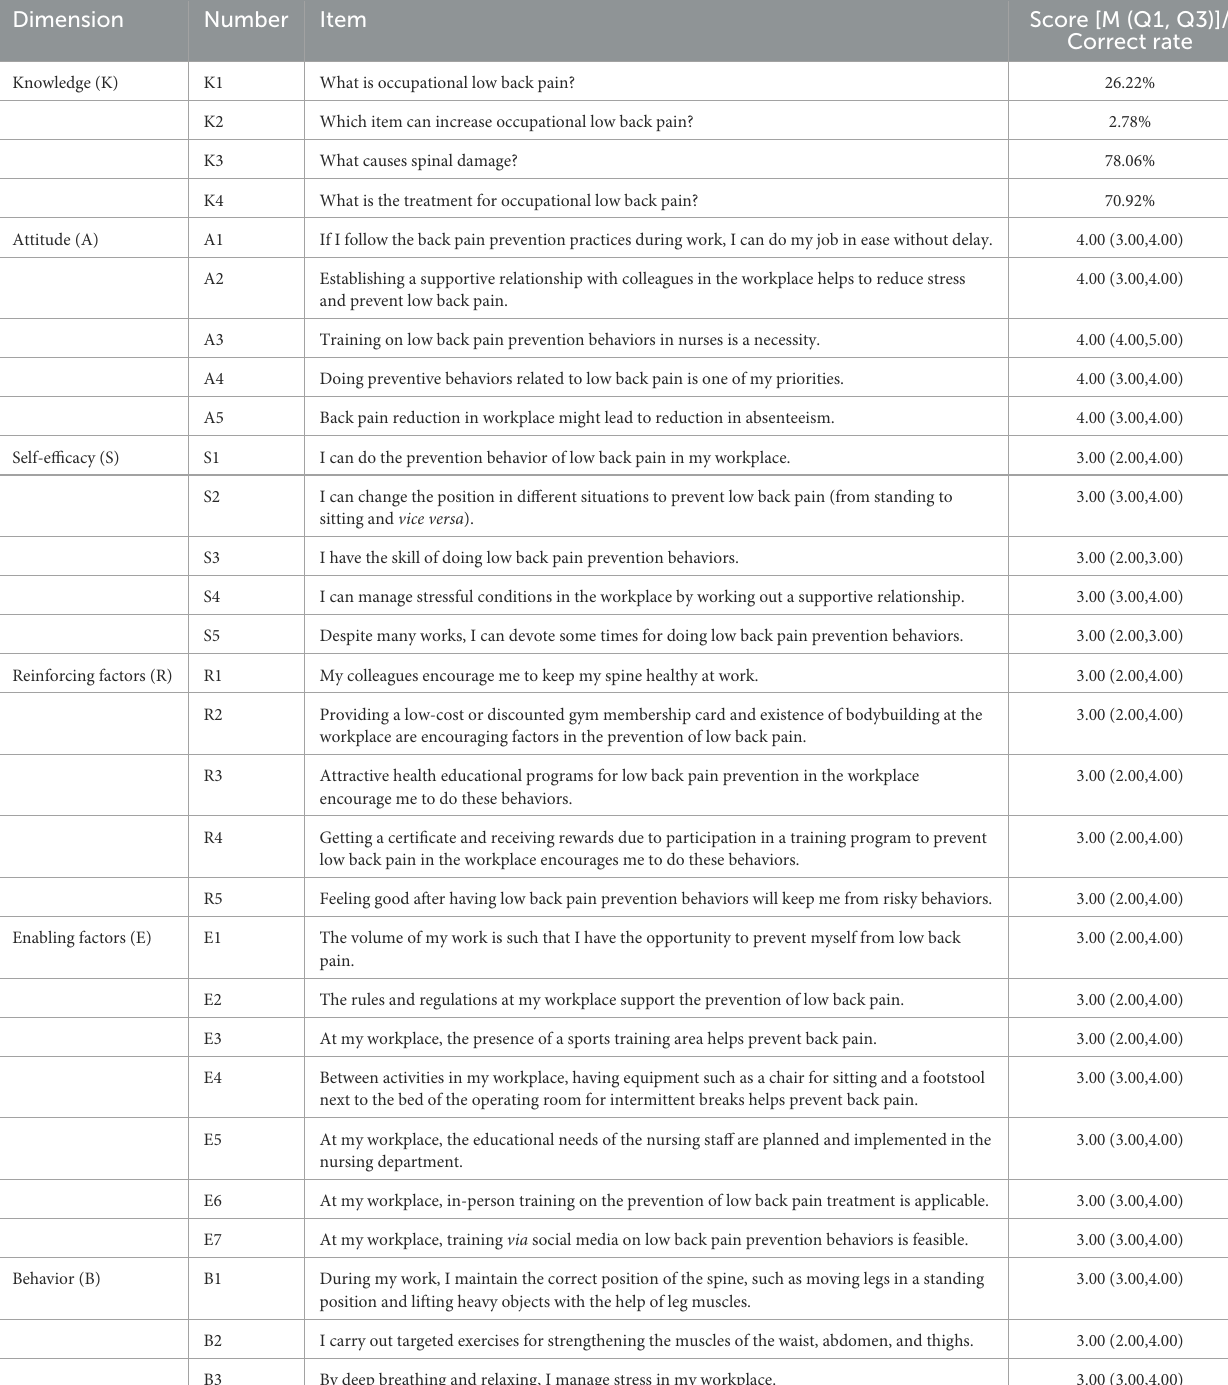
TABLE 2 The score of each item of the occupational low back pain prevention behavior questionnaire.